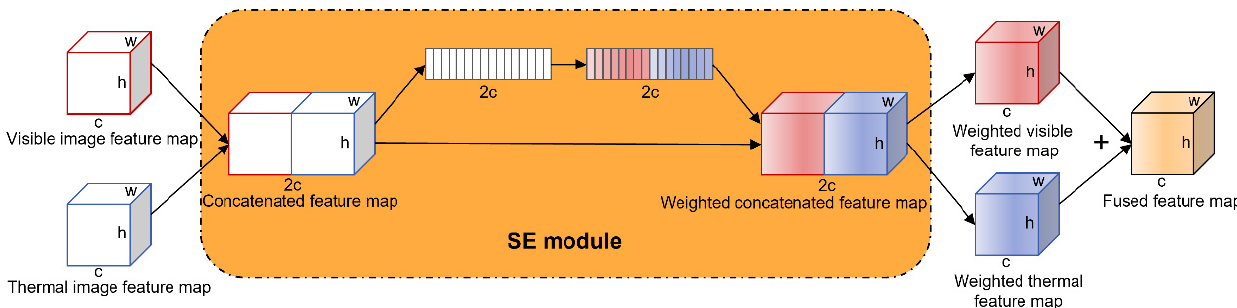
Figure 2. The use of a SE block to merge visible and thermal feature maps (the SE block is indicated in orange). Two branch feature maps are merged into one after an SE block.